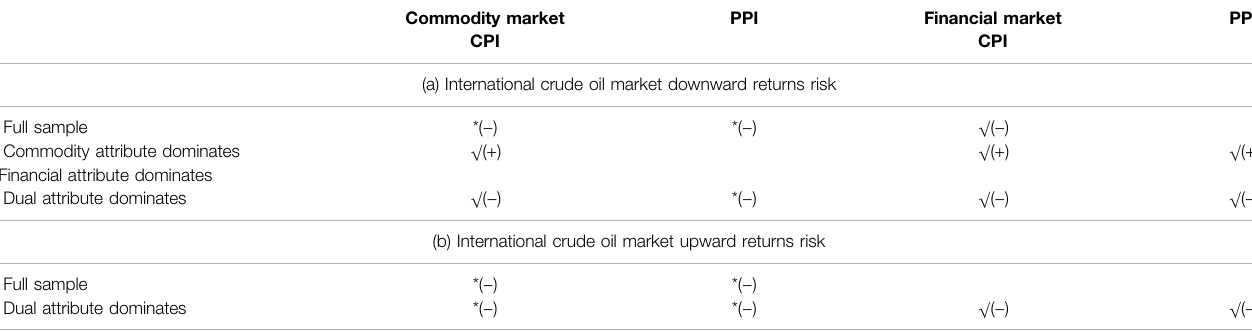
TABLE 10 | Comparison of the spillover mechanism of international crude oil market risk under different returns